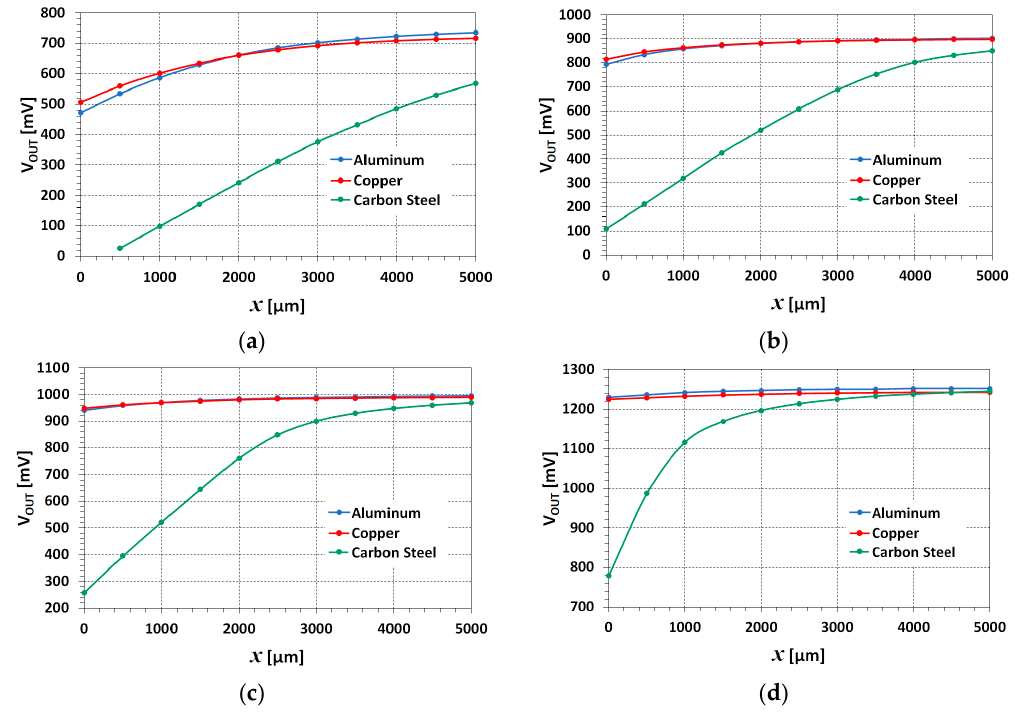
Figure 6. Comparison of the measured output voltage, V OUT , for the three considered 1 mm thick targets over the whole considered measurement range 0–5 mm for different values of V SUPPLY . ( a )